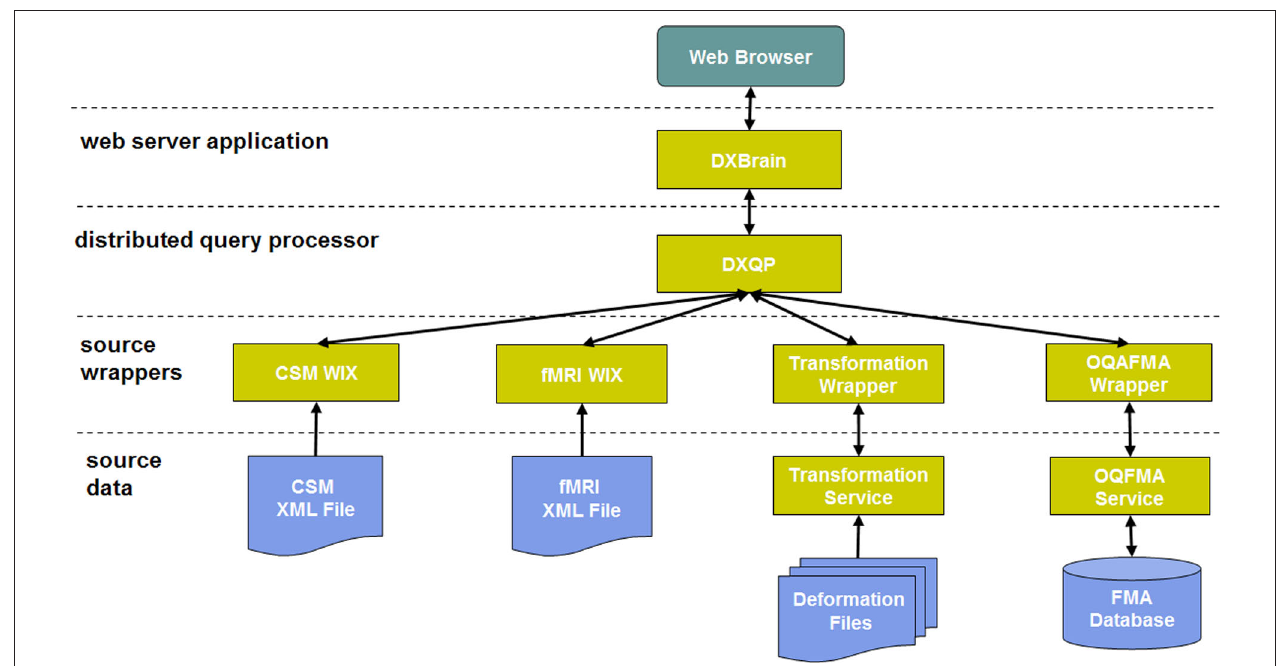
FIGURE 1 | System